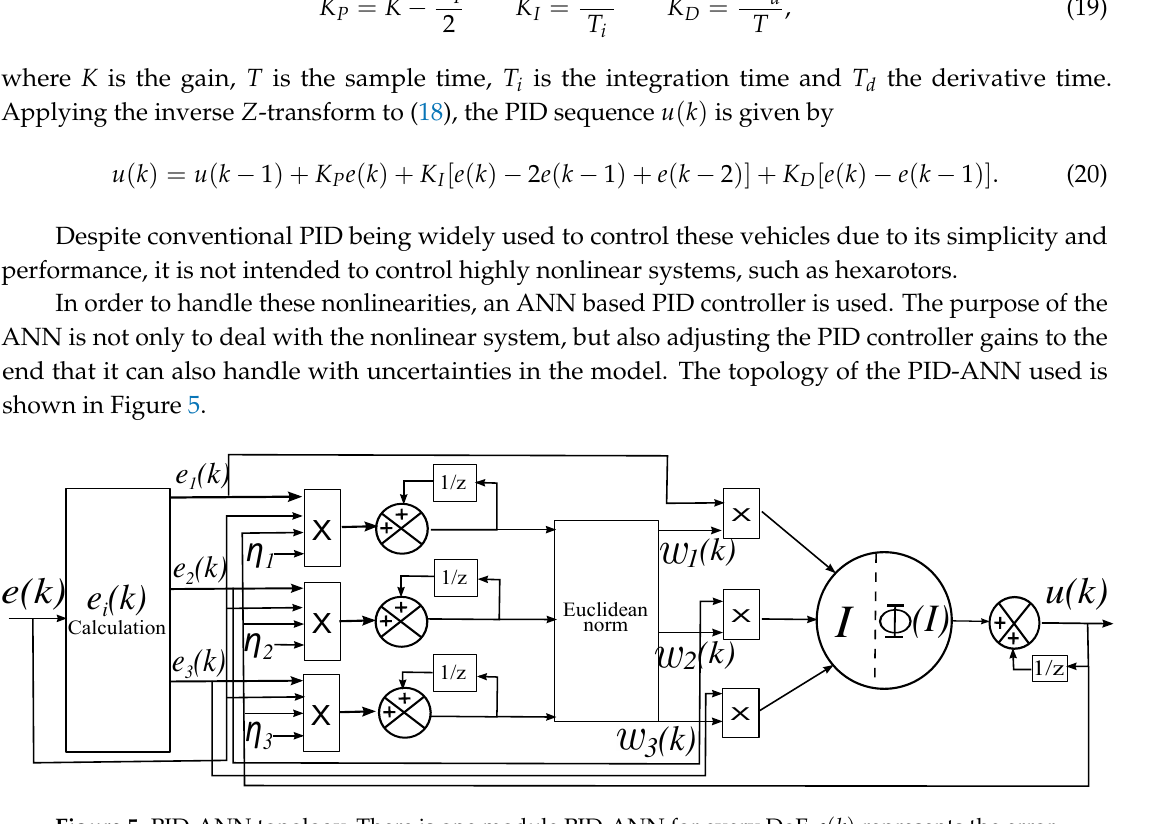
Figure 5. PID-ANN topology. There is one module PID-ANN for every DoF. e ( k ) represents the error in that DoF, e i ( k ) is a vector that represents the error, derivative of the error and the integral of the error and η i is the learning rate, which must be heuristically selected to be small enough to avoid saturation of the neuron and not necessarily the same for every gain (proportional, derivative and integral). The Euclidean norm block normalizes the neuron weights w i in order to avoid divergence since the neuron weights are the PID controller gains. The output of the neuron is the control input u ( k ) that will be traduced as thrust ( U 1 ), roll ( U 2 ), pitch ( U 3 ) or yaw ( U 4 ), depending on the state error at the input of the